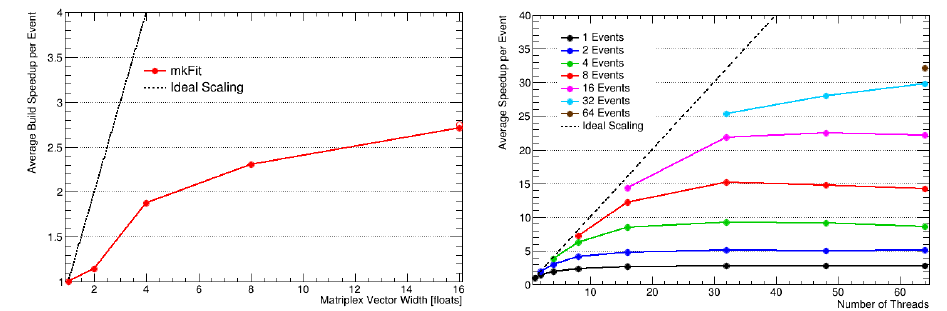
Figure 1. mkFit speedups on Skylake. Left: speedup of the single-threaded track building core algo- rithm as a function of the vector width configured in the Matriplex library; the open circle visible at a width of 16 floats corresponds to the usage of vector intrinsics code in Matriplex. Right: speedup of the full track building application as a function of the total number of threads (for vector width 16); di ff erent curves correspond to a di ff erent number of threads dedicated to event-level